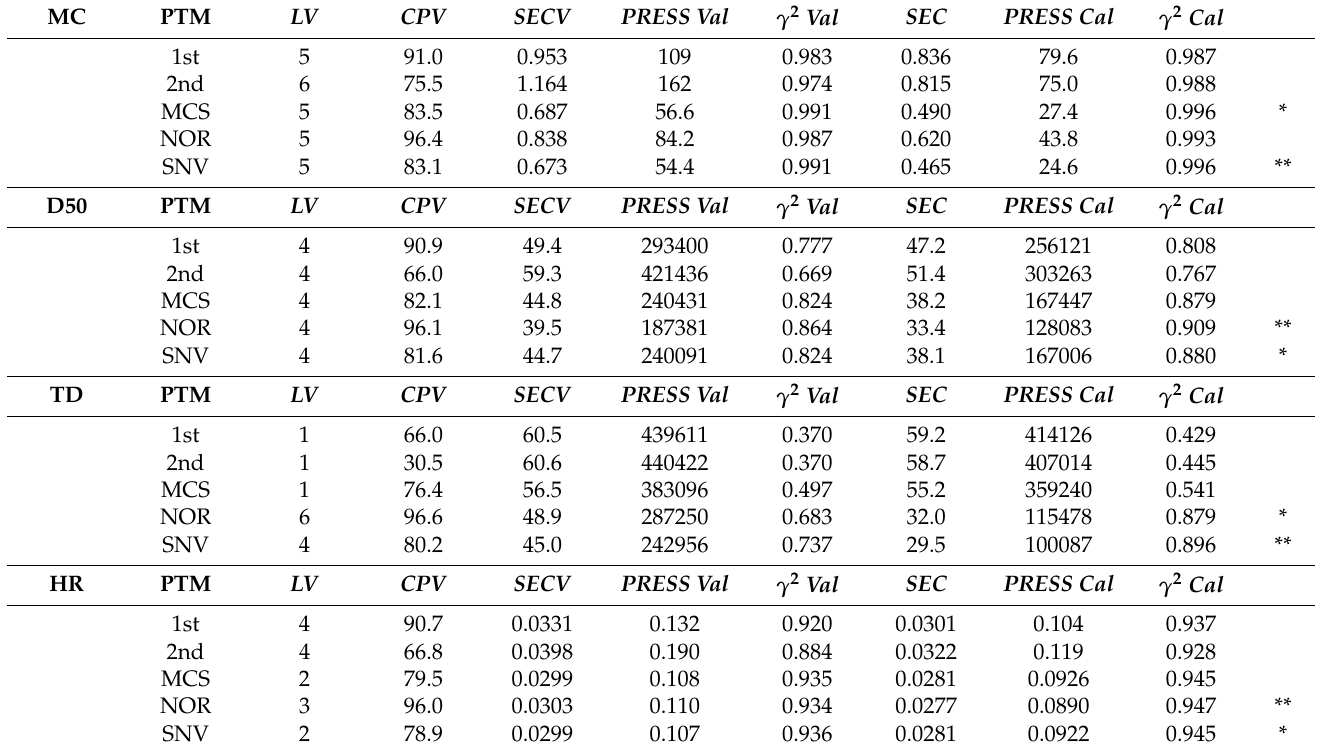
Table 3. Chemometrics parameters of the PLSR calibration models to predict pharmaceutical proper- ties of the HSWG granules based on various pre-treated NIR spectra.